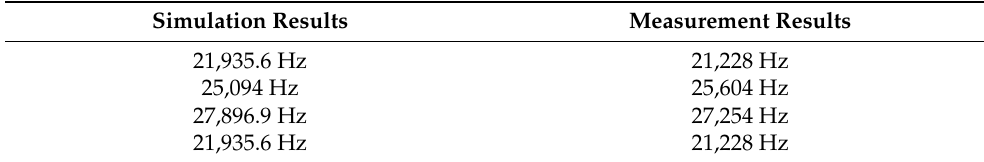
Table 2. Natural frequencies of the blade.